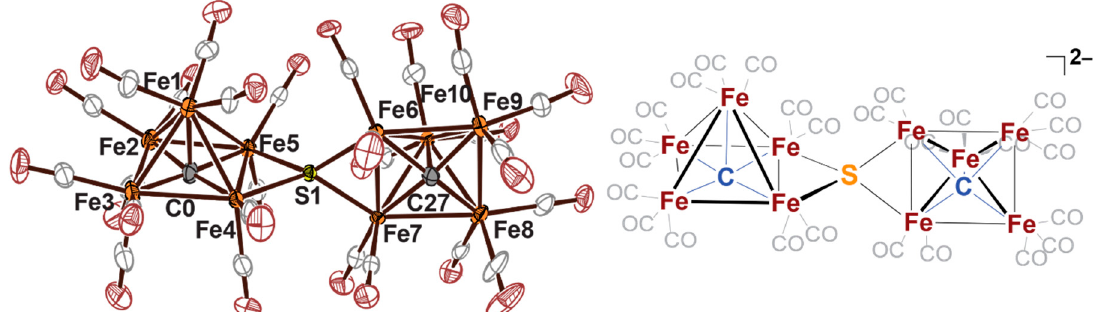
Figure 9. Thermal ellipsoid plots (50% probability) of (NEt 4 ) 2 {[Fe 5 ( µ 5 -C)(CO) 13 ] 2 ( µ 4 -S)} ( 4 ). Orange = Fe, Gray = C, Yellow = S, Maroon = O. Two NEt 4+ cations have been removed for clarity. Image adapted with permission from Joseph, C., Cobb, C. R., Rose, M. J. Single-Step Insertion of Sulfides and Thiolate